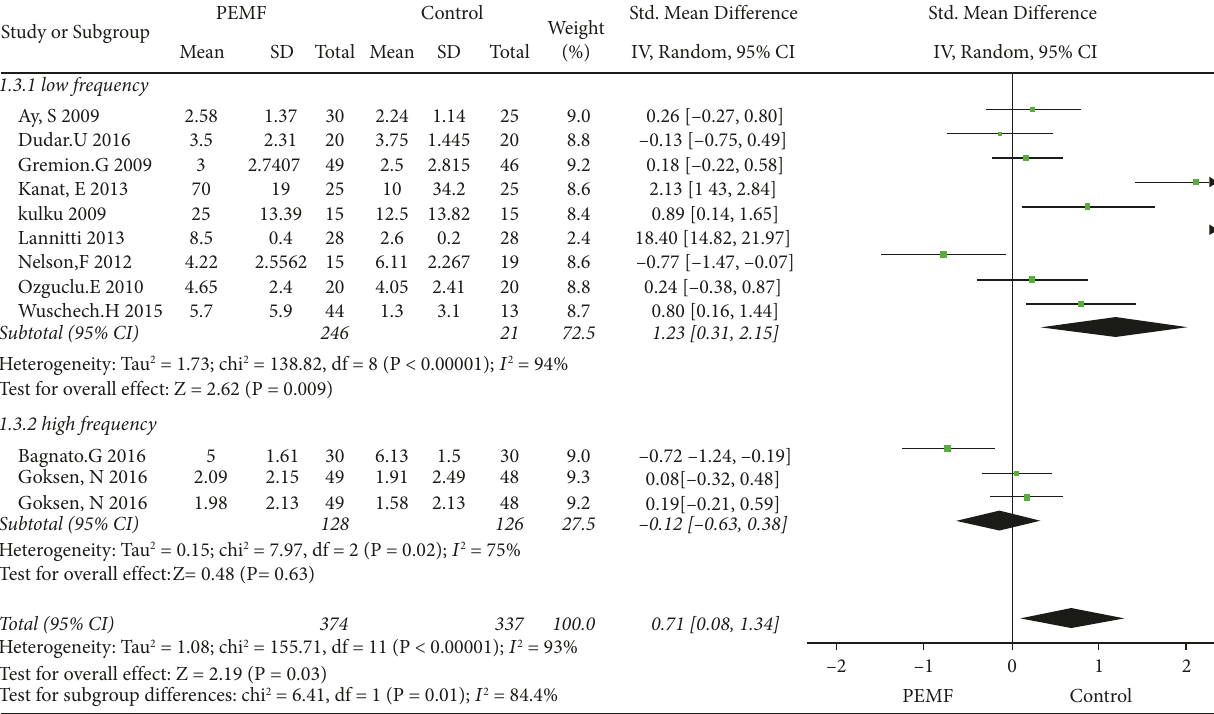
Std. Mean Difference IV, Random, 95%